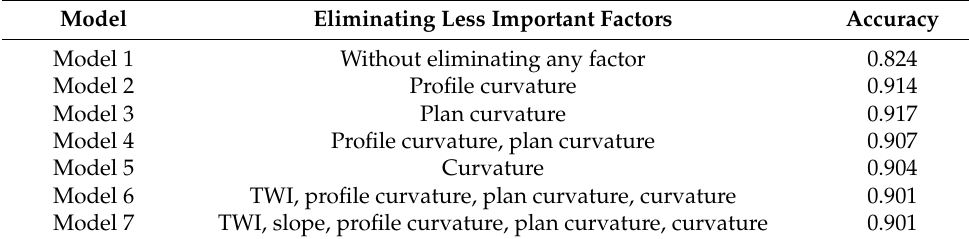
Figure 7. Causal factors importance plot. Table 3. The prediction accuracy after eliminating